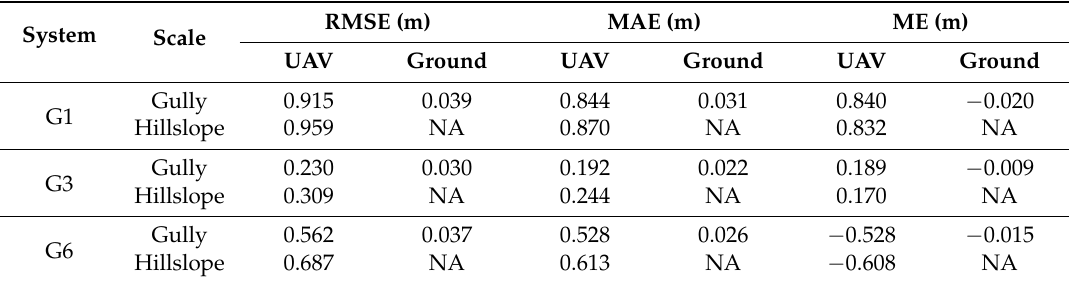
Table 5. Summary of the elevation errors in the comparison of RTK validation points and points extracted from UAV and ground dense point clouds (i.e., point-to-point